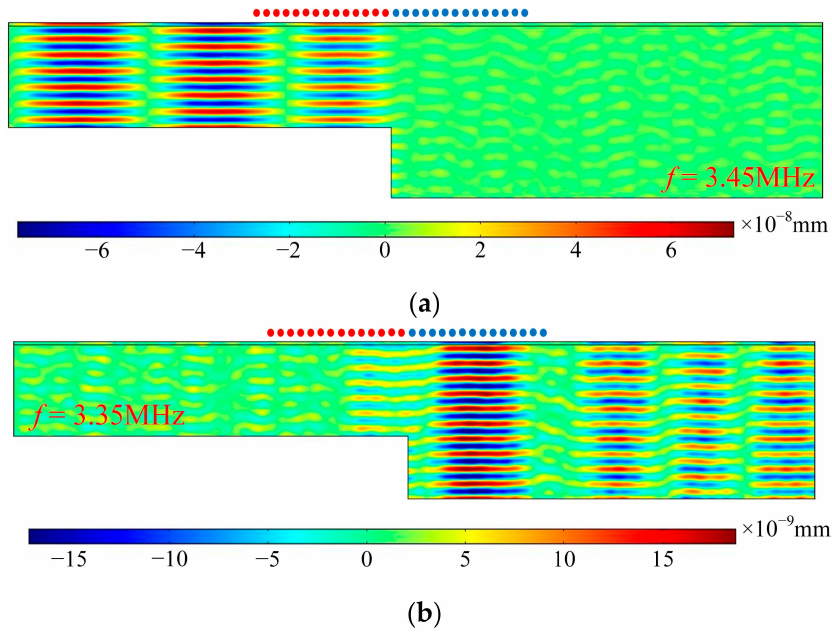
Figure 5. Resonant displacement diagram when coil group is located in the center. ( a ) Diagram of resonance on the 6 mm side at f = 3.45 MHz. ( b ) Diagram of resonance on the 10 mm side at f = 3.35 MHz.